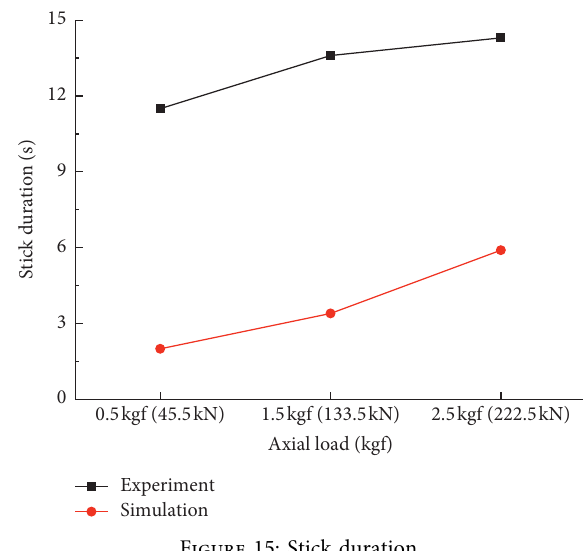
Figure 15: Stick